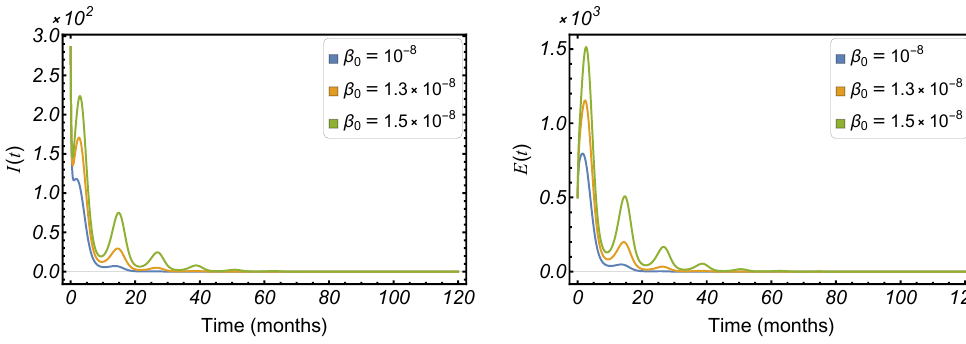
Figure 4. Extinction of measles when R 0 = 0.544246,0.70752,0.81637 < 1 with the parameters shown in Table